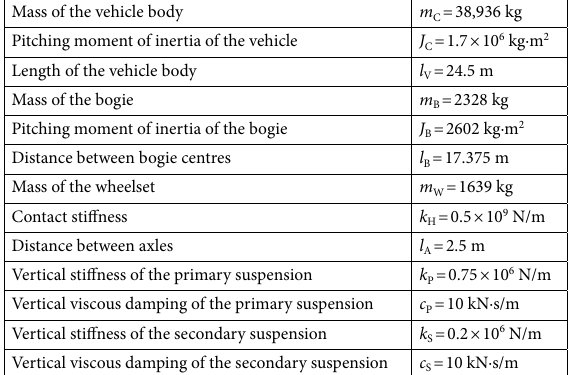
Table 5. Vehicle parameters.